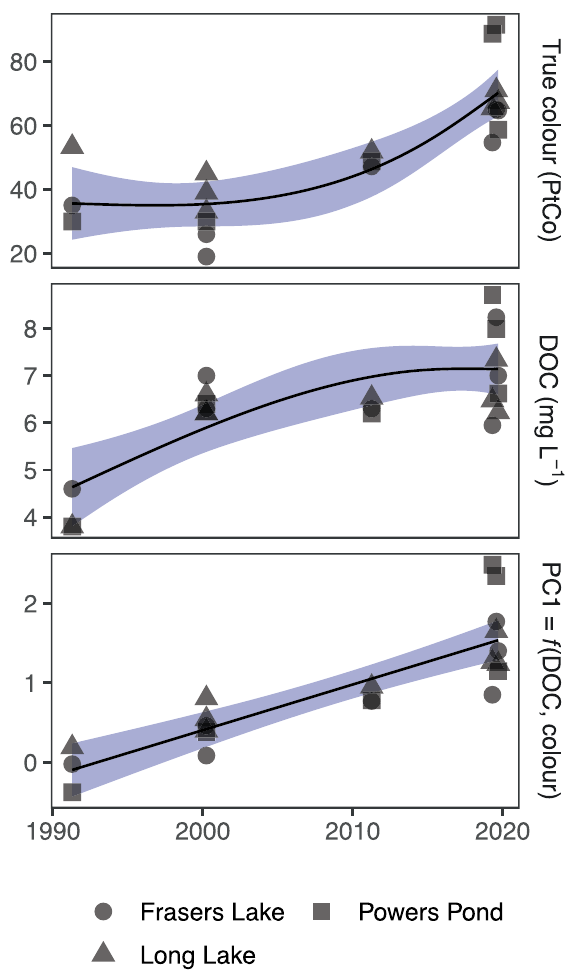
Fig. 2 Water quality trends in the high DOC study lakes. The fi rst principal component (PC1, 70% of total variance) describing variation in DOC and color is used as a summary metric for colored DOM; PC1 scales with the sum of (standardized) DOC and color (PC1 = 0.7 DOC + 0.7 color). The solid lines in all panels represent cubic regression splines fi t to the data, and the shaded regions de fi ne a pointwise 95% con fi dence interval on the fi tted values. Data before 2019 are due to Clement et al. 42 or Clement and Gordon 43 and were otherwise collected as part of this study (Table